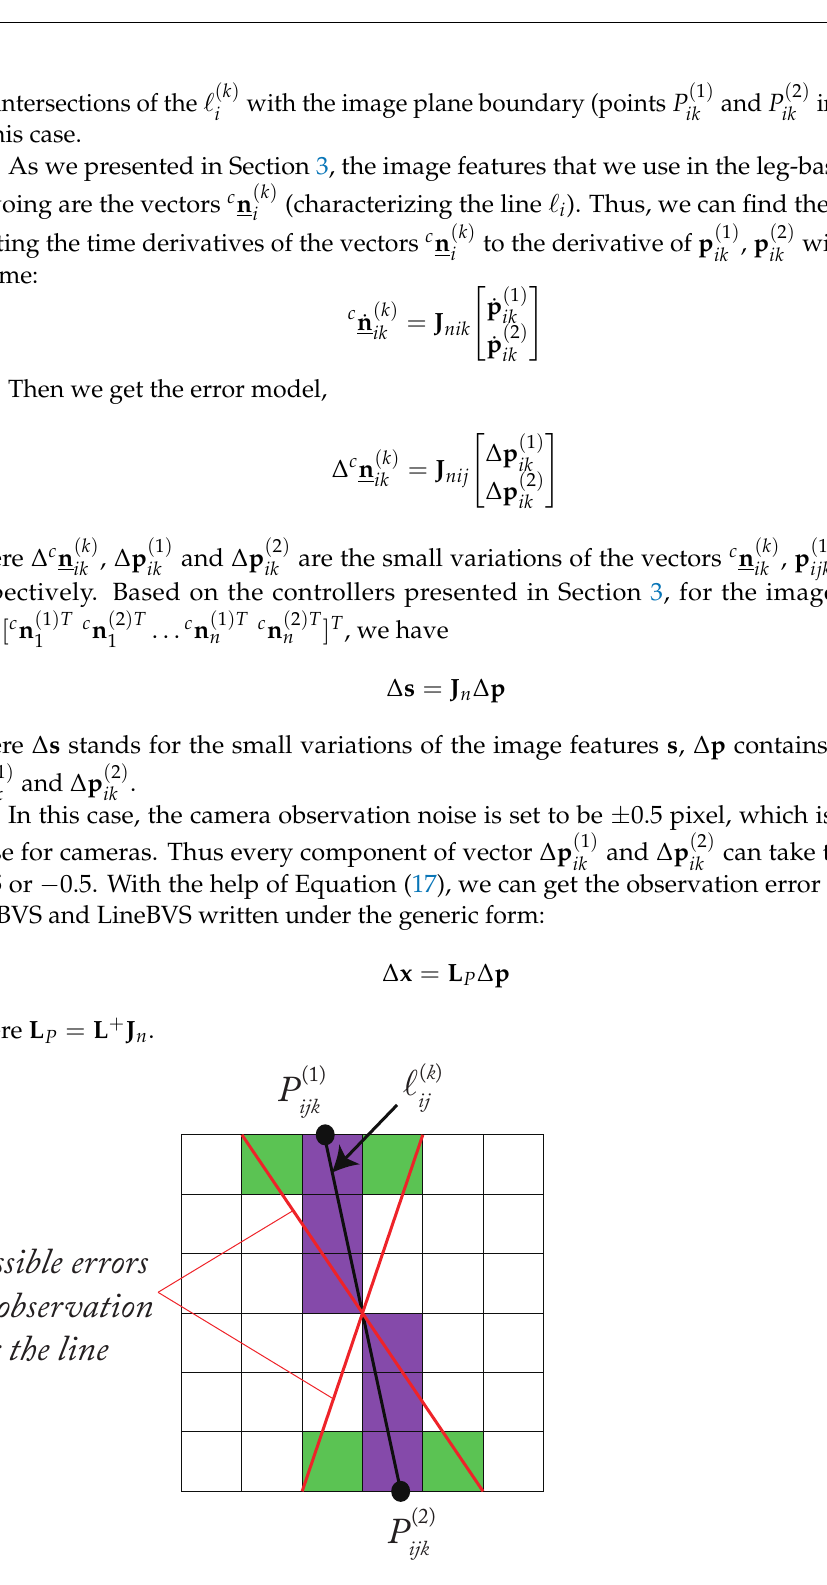
Figure 8. Error for the observation of a